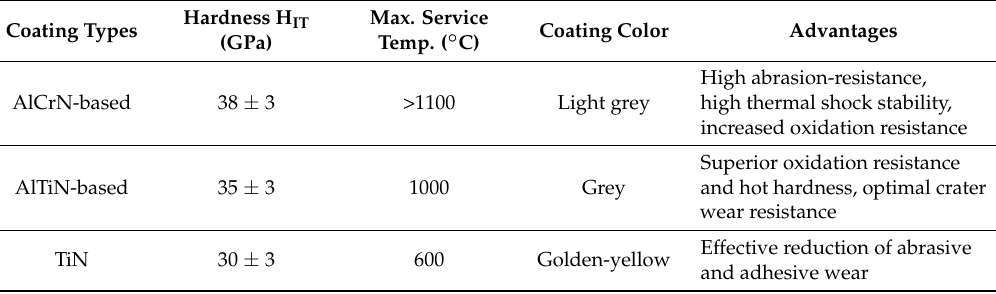
Table 2. Characteristics of the different coating materials.